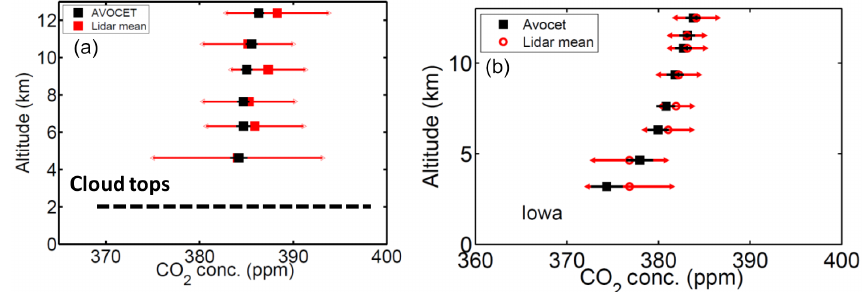
Figure 9. The XCO 2 retrievals for lidar measurements to the tops of broken cumulus clouds (a) and to the ground (b) on the 10 August 2011 ASCENDS flight over Iowa. The XCO 2 values from the in situ AVOCET gas analyzer are marked in black squares, and the values of XCO 2 retrievals from CO 2 Sounder measurements averaged over 10s are marked in red circles with error bars of ± 1 standard deviation. The average altitude of cloud tops ( ∼ 2km) is plotted in the dashed line.